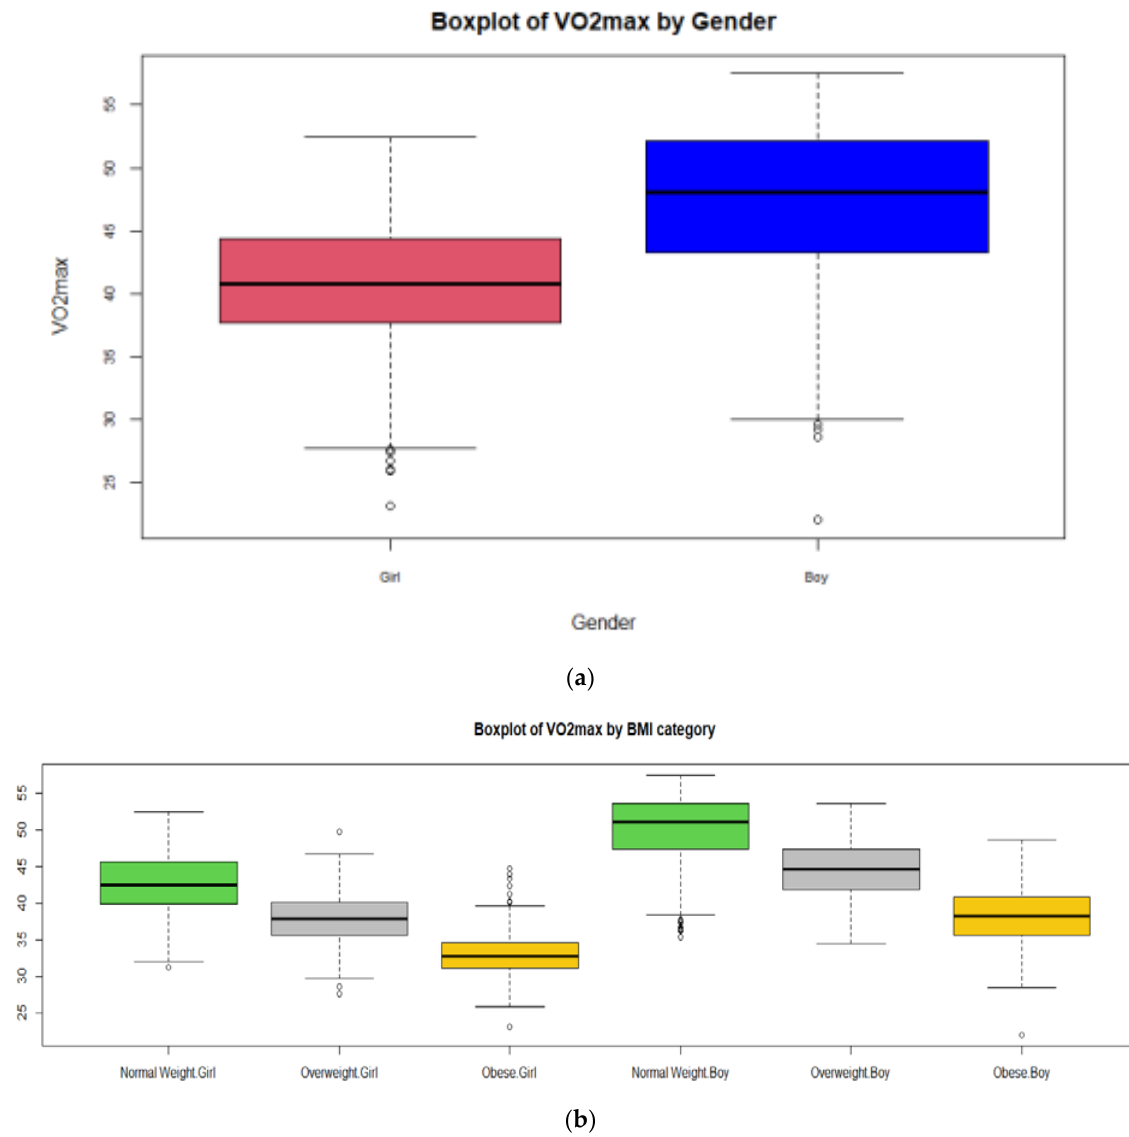
boys played basketball (U = 533,268, p < 0.001) and football (U = 288,862, p < 0.001) more